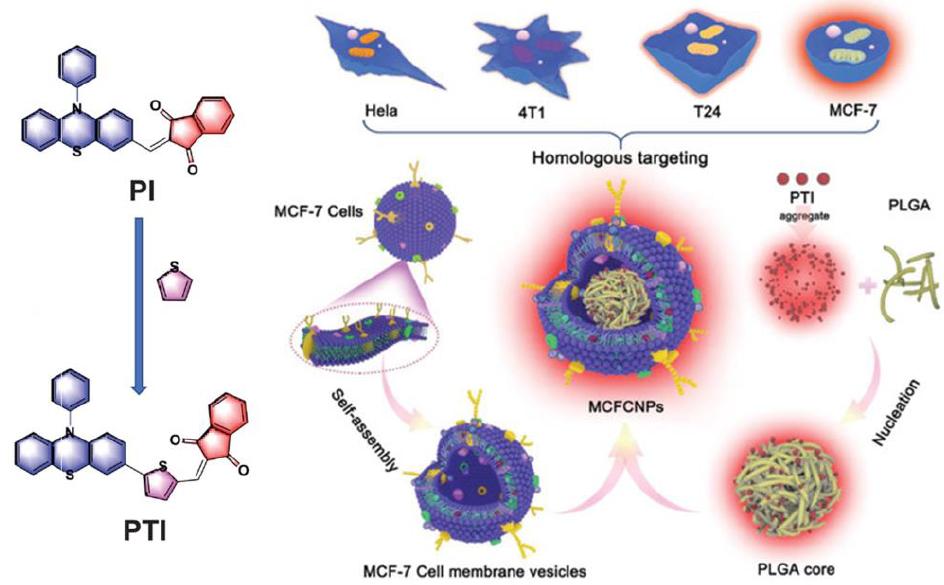
Figure 12. Schematic illustration of chemical structures and mechanisms of TACQ. Reprinted with permission from Ref. [124]. Copyright 2021 WILEY-VCH.